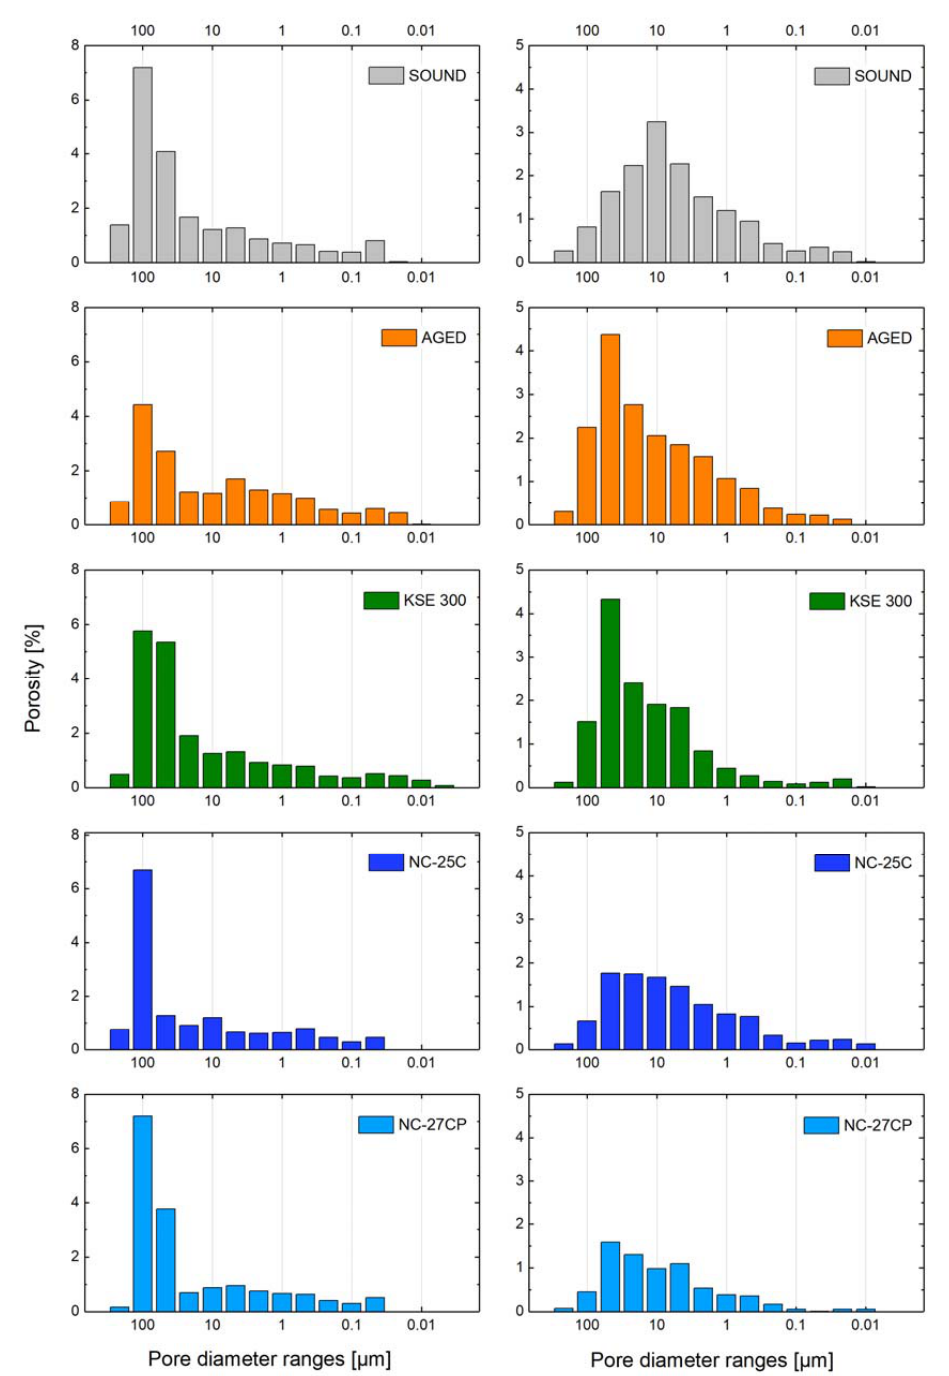
Figure 3. Range of porosimetric parameters (pore radii distribution and open porosity by Hg-intrusion) for the—from top to bottom—sound, aged and consolidated (KSE 300, NC-25C and NC-27CP) conditions determined by mercury intrusion porosimetry; six months after consolidation treatment: values for St. Margarethen Limestone ( left side ) and Schlaitdorf Sandstone ( right side ).